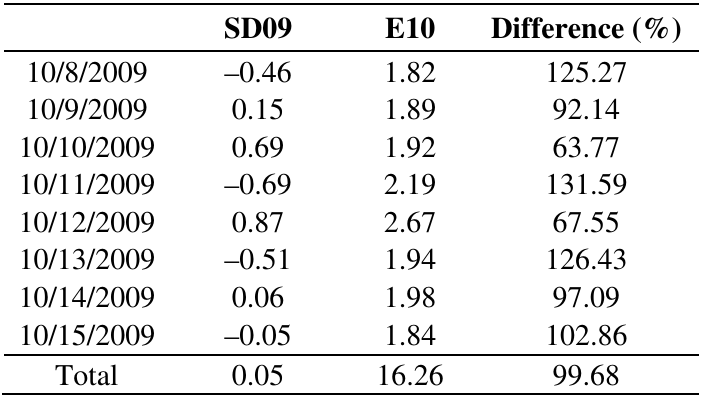
Table 4. Average daily net